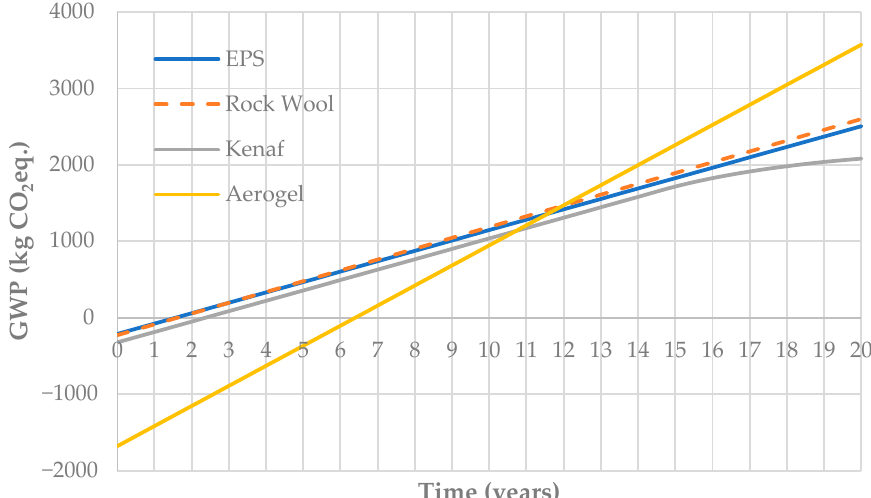
Figure 11. Cumulative GWP for every retrofit intervention (positive values stand for emissions avoided).